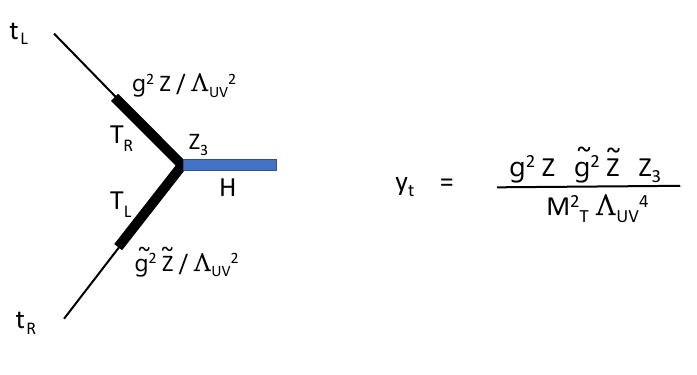
Figure 8. The diagram responsible for the generation of the top Yukawa coupling. t L , t R are the standard model top quarks, T L , T R the top partners — they mix via the HDOs with couplings g and ˜ g — there are Z form factors associated with the formation of the top partner baryons. H is the pNGB that becomes the Higgs which has an order one Yukawa coupling to the top partners Z 3 . Here the Z factors are three structure functions that depend on the strong